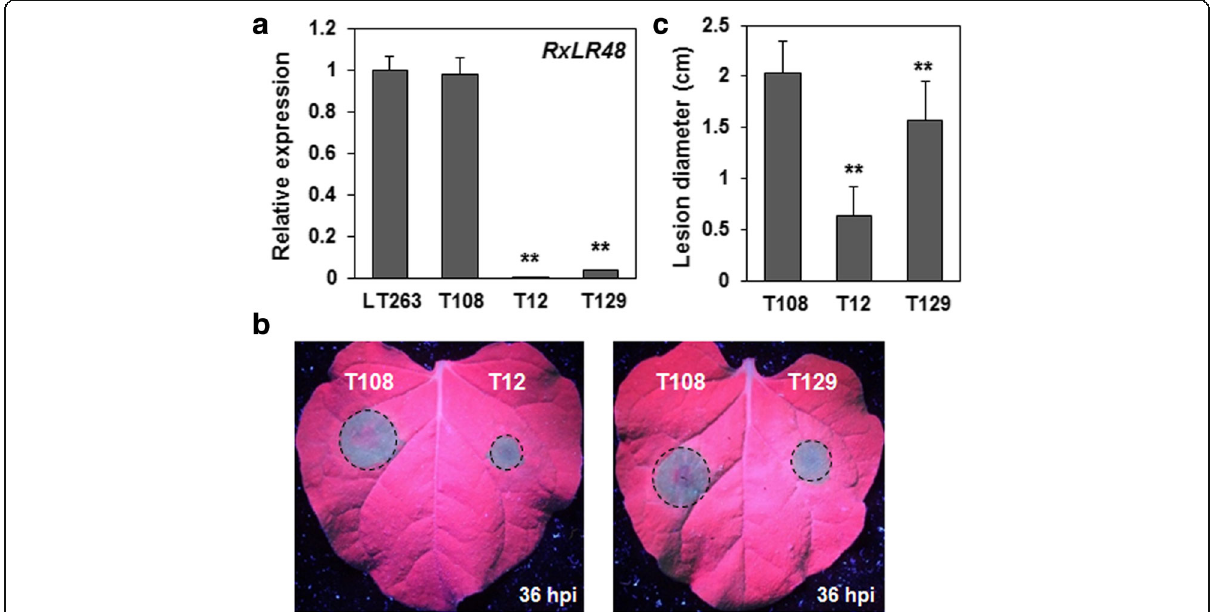
Fig. 3 RxLR48 contributes to Phytophthora capsici virulence. a Relative expression levels of RxLR48 in P. capsici transformants. Total RNA was isolated and transcript levels of RxLR48 were determined by qRT – PCR with P. capsici tubulin gene as a pathogen reference. T108 was a non- silenced transformant carrying the same silencing construct. (**, P < 0.01 compared with LT263, Dunnett ’ s test). b , c Inoculation of RxLR48 -silenced transformants . Leaves of Nicotiana benthamiana were inoculated with the non-silenced transformant T108 (control) and RxLR48- silenced transformants T12 and T129. Photographs ( b ) were taken under UV light and lesion diameters were measured at 36 hpi. The shown data ( c ) are expressed as the mean + SD of three replicates. Asterisks indicate significant differences (**, P < 0.01 compared with T108, Dunnett ’ s